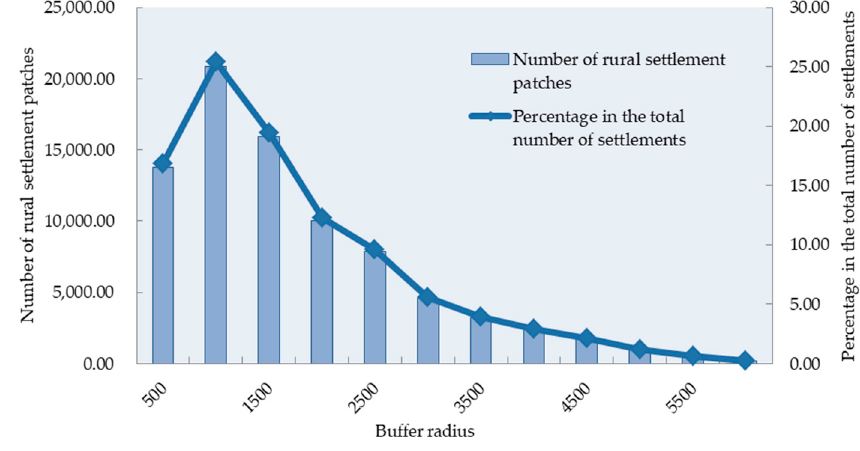
Figure 8. The rural settlements in different distance zones to roads in Nanjing.